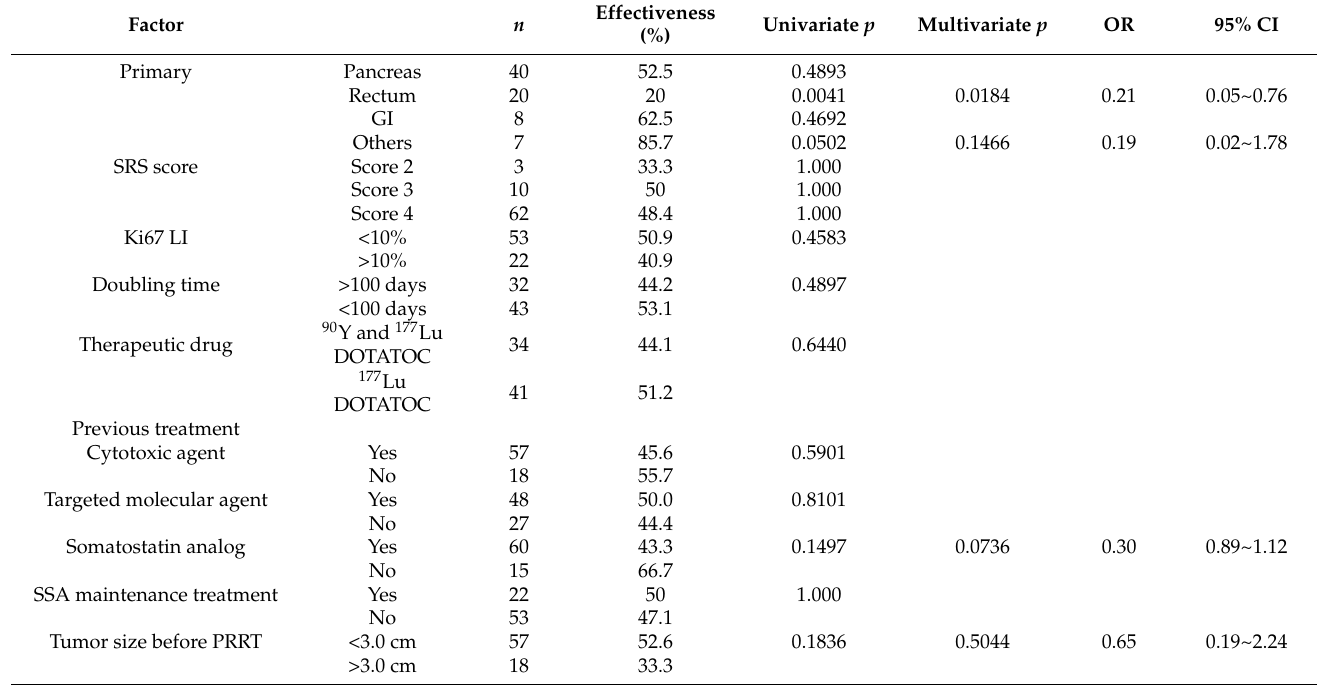
Table 3. Univariate and multivariate analysis of factors affecting tumor shrinking effect of PRRT in lesion-based